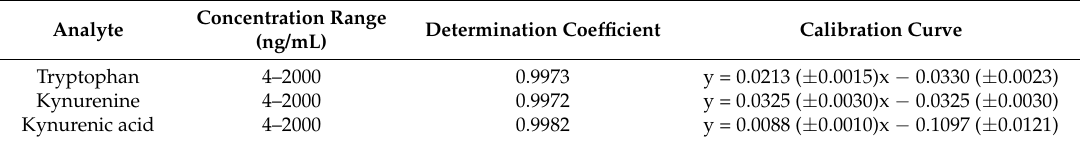
Table 1. Parameters obtained for the calibration curve.